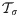
Influence of γ-modulation on spatial learning in a cell assembly network with coincidence detector readout neurons.There are two major parameters of the model: the mean width of the temporal window w over which the postsynaptic readout neurons integrate spikes from the place cell assemblies (w1 = 2Tθ, w2 = 1.2Tθ, w3 = 0.8Tθ, w4 = 0.5Tθ, w5 = 0.3Tθ, w6 = 0.2Tθ, with larger windows w represented by thicker lines), and the effective temperature 1/β which controls the clustering of place cells’ spikes around the troughs of the γ-wave (Fig 2). Larger values of β (indicated by the blue color of the colormap) correspond to tighter coupling between the place cell’s spiking probability and the γ-amplitude (S2 Fig). A: The number of 2D simplexes, N2, in the coactivity complex Tσ as a function of β, for different w’s. For large integration windows (thicker lines), coupling with the γ-wave produces no significant effect: the N2 changes less along the β-axis. As w decreases, the number of simplexes drops (the thinner lines lay below the thicker ones). However, the smaller the integration window w, the greater the number of coactive place cell combinations, produced by the cooling of the cell assemblies. For w = Tγ (bottom curve) the number of 2D simplexes grows by 40% as β increases from 0 to 2. B: Shrinking the integration window w increases the total number of topological loops observed in Tσ during the course of learning, whereas cooling down the coactivity complex reduces this number. For example, the number of spurious loops in cold coactivity complexes (cold loops, β = 2) at w = Tγ is half the number of those in hot complexes (hot loops, β = 0). C: The learning time Tmin grows as w shrinks and tends to decrease as a function of β. However, note that even cold simplicial complexes fail to produce the correct topological maps for small w. In the particular map illustrated here (mean place field size s = 24 cm, mean firing rate f = 20 Hz, Nc = 450 cells), learning time diverges at w ≥ 0.5Tθ.